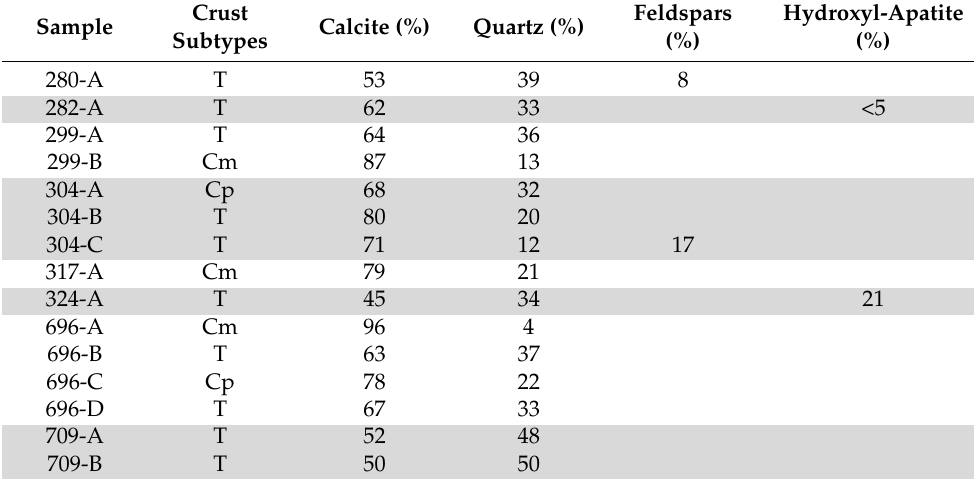
Figure 5. Microphotographs of indeterminate bone fragments: ( A ) microcracks affecting bone surface (Sample 280); ( B ) detail of splintered bone fragment (Sample 324); ( C , D ) calcite aggregates and Fe–Mn precipitates, respectively, filling osteonal cavities (Sample 282); ( E , F ) thin silty micritic crust on bone surface, with detail of calcite crystals filling osteonal channels and other micropores (Sample 282). Microphotographs ( A – C , E ) were taken under plane-polarized light; ( D , F ) were taken under crossed nicols. Table 2. Mineral composition of the analysed samples. See Figure 4 for the location of each sample. Sample